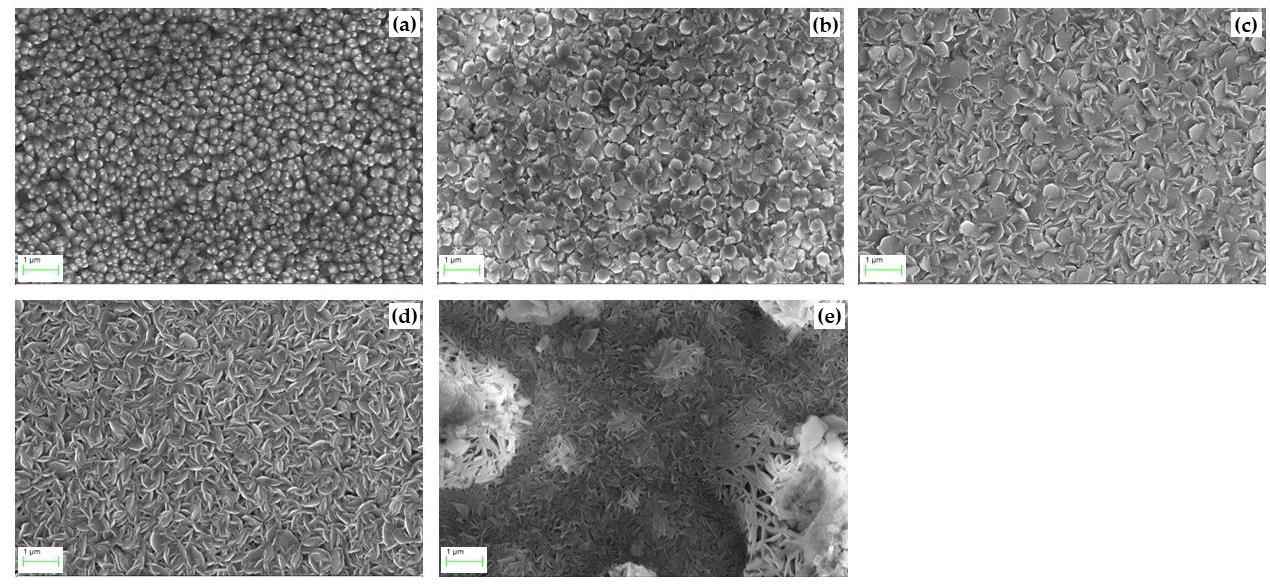
Figure 10. SEM image of the ZnO thin film at temperatures of ( a ) 593 K; ( b ) 613 K; ( c ) 633 K; ( d ) 673 K; and ( e ) 713 K.